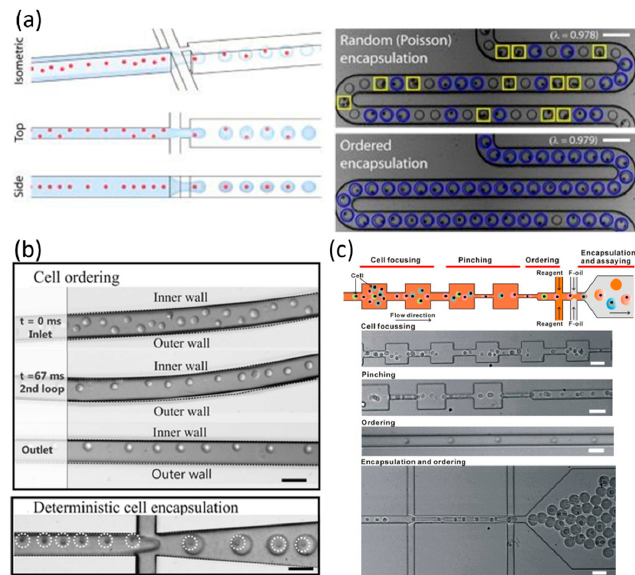
Figure 3. Inertial flow-based cell spacing and single-cell encapsulation using ( a ) a high aspect-ratio straight microchannel (reproduction with permission from [41]); ( b ) a curved microchannel (reproduction with permission from [42]); and ( c ) a short pinched flow channel (reproduction with permission from [43]).